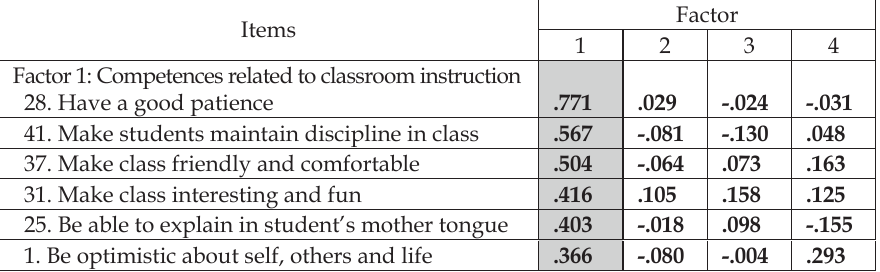
Table 2. Factor model of a good English language teacher for English language and literature